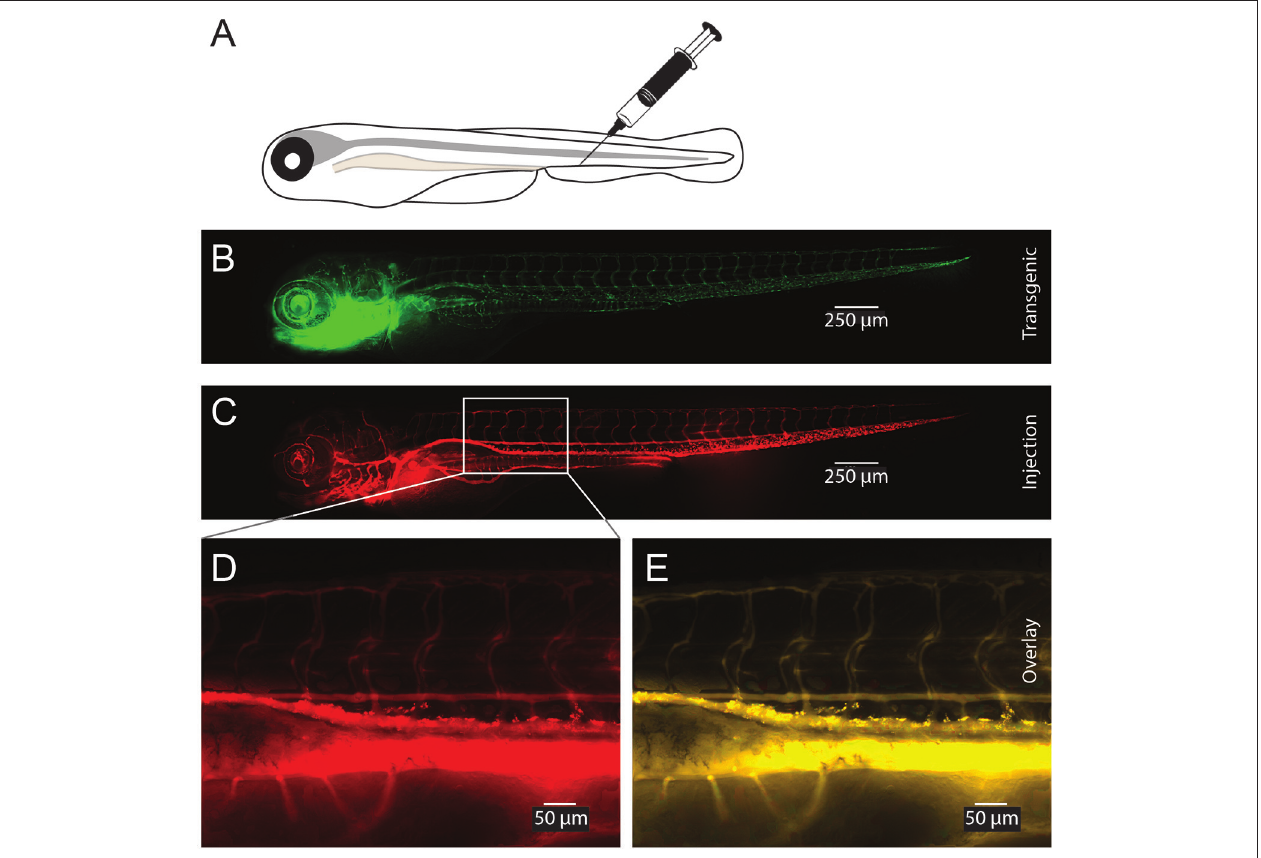
FIGURE 3 | Visualization of CaP-lipid NPs after tail vein injection in transgenic zebrafish. Sterile filtered non ASO-loaded CaP-lipid NPs containing LissRdB-DSPE (stock, 1:5 or 1:10 v/v) was injected into the vein of zebrafish expressing a green fluorescent reporter in their vasculature (Tg(fli1a:EGFP)). Schematic illustration of the route of injection (A) . Expression of EGFP in transgenic fish highlighting the blood vessels (B) . Visualization of CaP-lipid NP in 6-day-old transgenic zebrafish 2 h after injection (C) . Zoomed image of the treated zebrafish from area indicated by white box, showing distribution and accumulation of CaP-lipid NP in and around blood vessels (D) . Overlay of transgenic EGFP expression and CaP-lipid NP distribution (E)